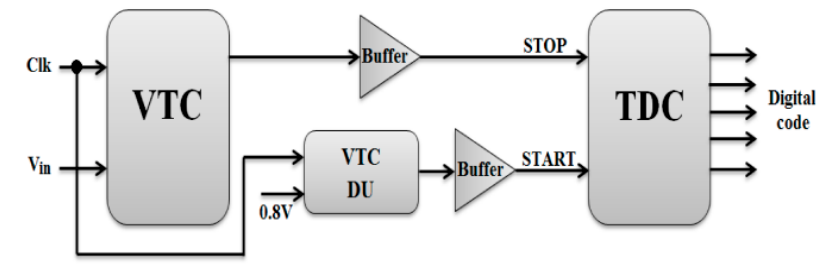
Figure 26. Interface circuit for the second proposed VTC.